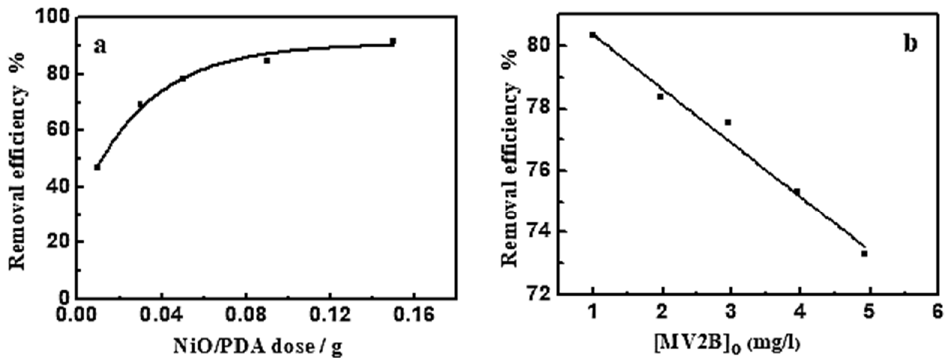
Figure 5. ( a ) Effect of NiO/PDA dose on the removal efficiency of MV2B. (MV2B) o = 2.95 mg L − 1 , ( b ) effect of initial concentration of MV2B on its removal efficiency, NiO/PDA = 0.05 g, at 30 ◦ C at 30 min.